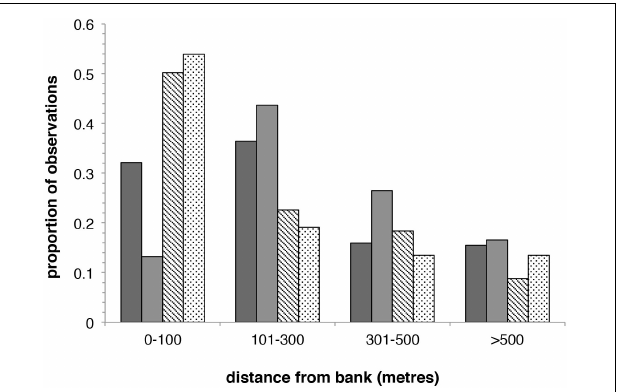
FIGURE 2 | Proportions of porpoise observations and reported use of fishing gears in four distance-from-bank bins across Yangtze mainstem. Dark gray, 2006 porpoise data ( n = 439); mid-gray, 2012 porpoise data ( n = 181); hashed bar, free-floating nets ( n = 283); dotted bar, hook-type gears ( n = 89).